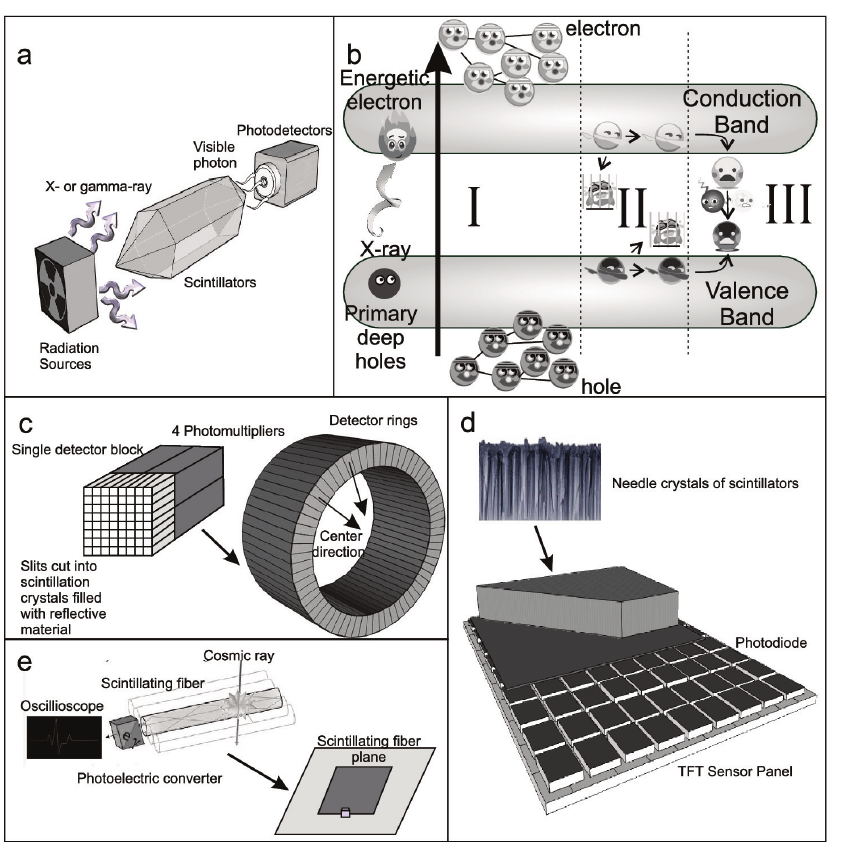
Figure 1. Construction, process, and applications of scintillators: ( a ) A scintillation detector with the main constituent parts. ( b ) A sketch of the scintillator process in crystal. The process is divided into three consecutive stages of (I) conversion, (II) transport and (III) luminescence, which are described in the text. ( c ) Schematic of a detector block and ring of scintillators in a positron emission